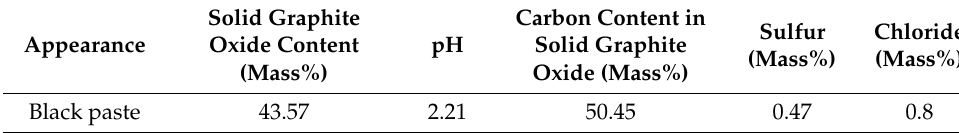
Table 2. Graphite oxide